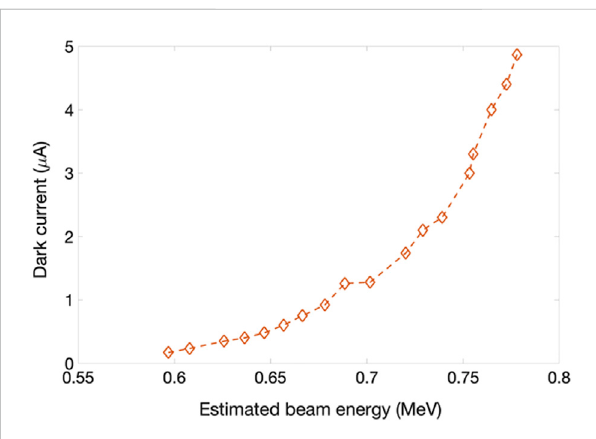
FIGURE 5 LCLS-IIRFgundarkcurrent3 mfromthecathode versus thegun energy gain.